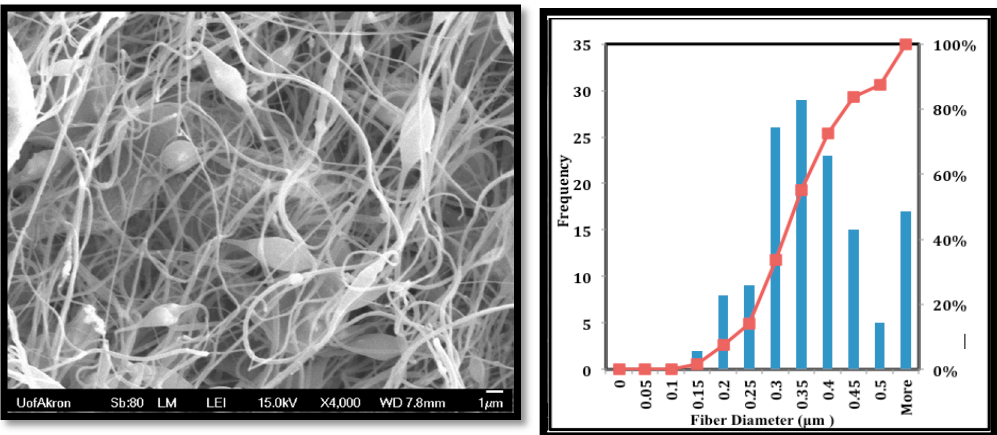
Figure 3. Scanning electron microscopy (SEM) images of the PVDF-HFP nanofibers.